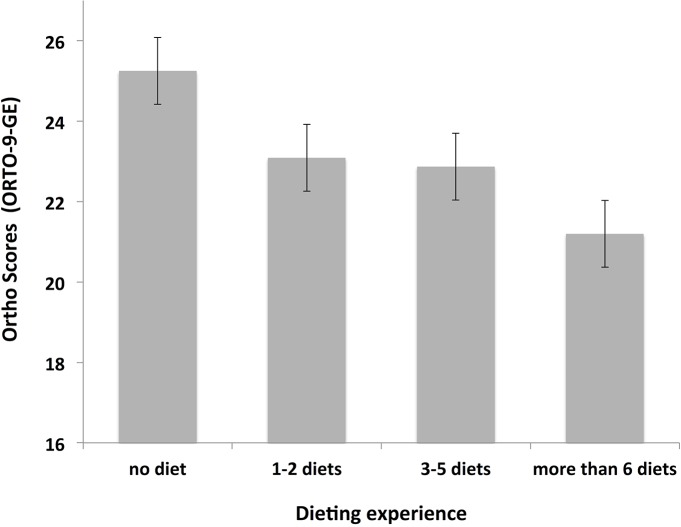
ORTO-9-GE scores associated with dieting experience.ORTO-9-GE scores as a function of dieting experience (range: no dieting experience to > 6 diets). Lower ORTO-9-GE scores indicate higher orthorectic tendencies. Error bars indicate standard errors of the means.